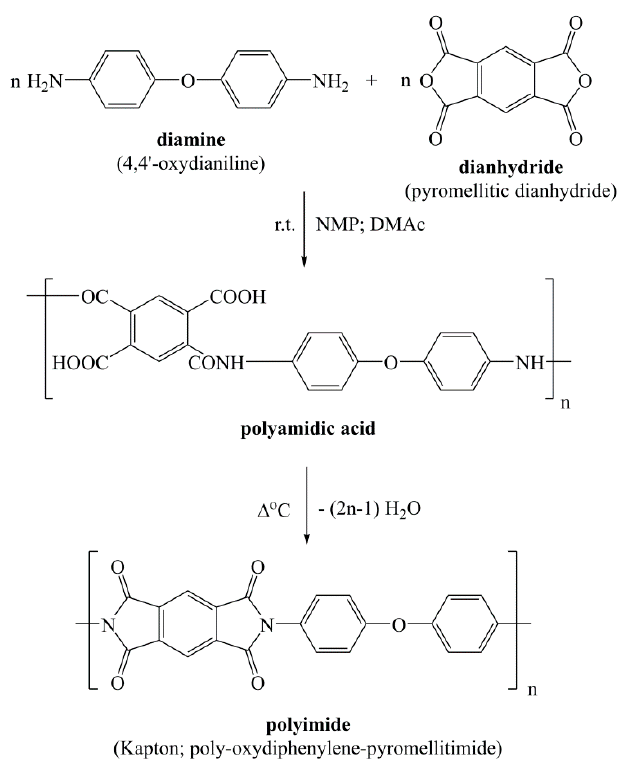
Scheme 1. Schematic representation of the two-step synthesis of a conventional